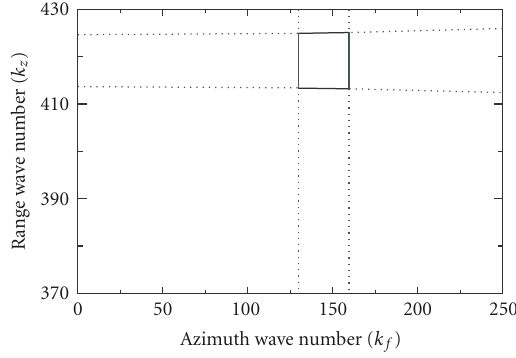
Figure 2: Illustration of the data spectrum after the modified Stolt mapping within the defined bandwidths (squint angle = 20 ◦